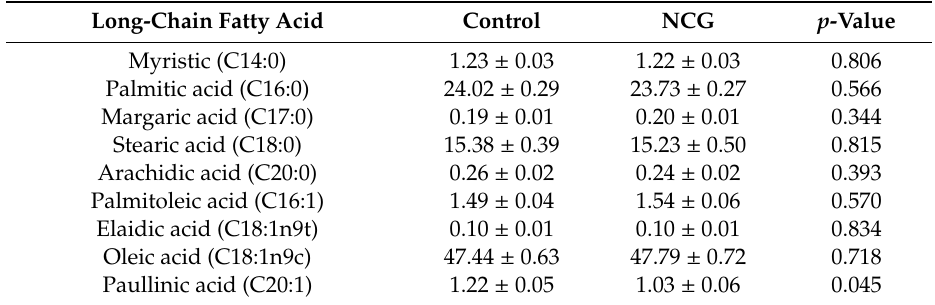
Table 5. E ff ect of dietary N -carbamylglutamate on long-chain fatty acid composition (% of total fatty acids) in the dorsal subcutaneous adipose of Ningxiang